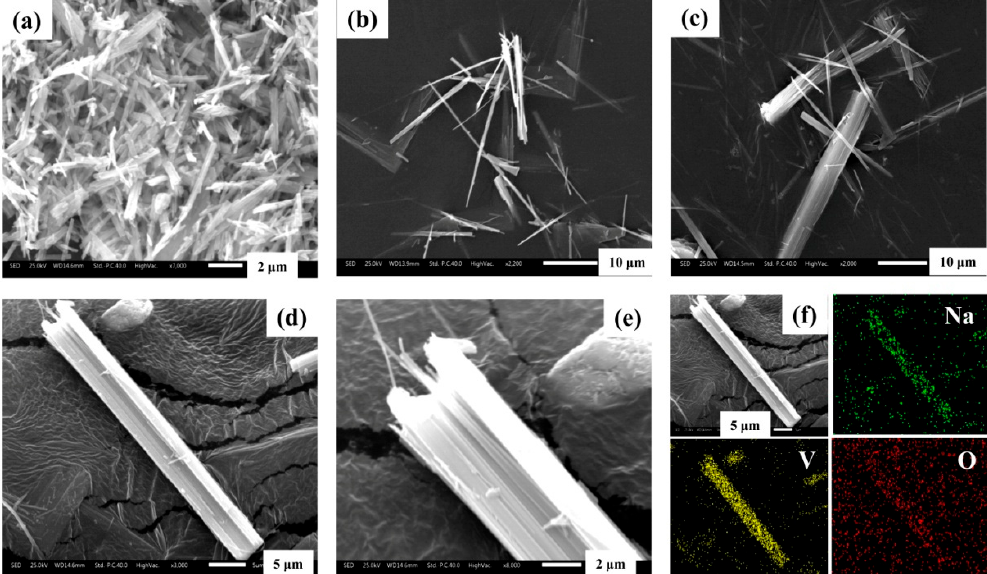
Figure 14. Scanning electron microscopy (SEM) image of the products obtained at different reaction times of ( a ) 0.5 h, ( b ) 1 h, ( c ) 1.5 h, and ( d ) 2 h under an initial solution pH value of 4, a reaction temperature of 200 °C, and a H 2 gas partial pressure of 4 MPa. ( e ) The partial magnified image; ( f ) energy-dispersive spectrometry (EDS) element mapping analysis of the product obtained at 2 h.